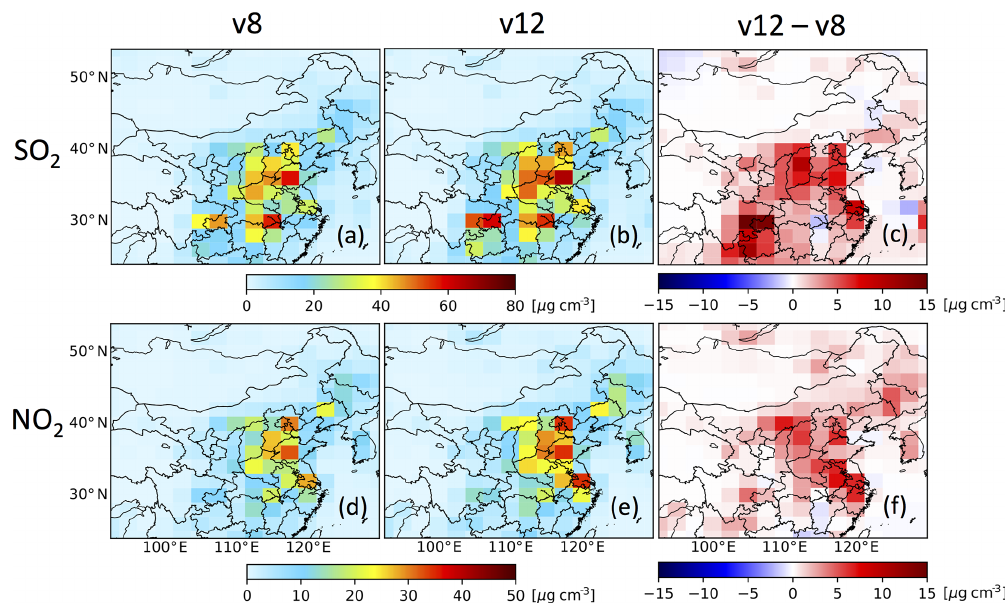
Figure 1. Simulations of surface SO 2 and NO 2 concentrations for October 2013. Panels (a) and (b) show surface SO 2 simulated by GC adjoint v35m (developed based on GEOS-Chem version 8.2.1, updated through version 9, and we name it v8 for short) and GCv12.0.0 (v12 for short), respectively, and (c) shows the difference between v12 and v8. Panels (d) – (f) are similar to (a) – (c) but for NO 2